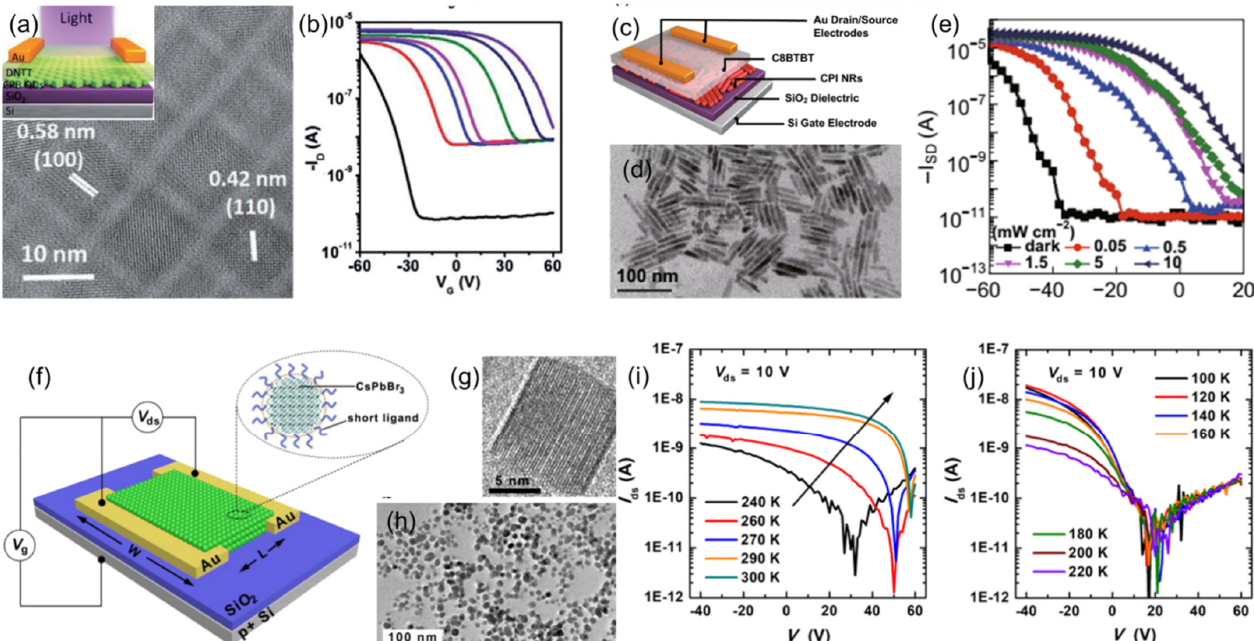
Figure 9. ( a ) HRTEM image of CsPbBr 3 quantum dots (inset: device schematic of the FET) and ( b ) transfer characteristic curves under different illumination conditions. Reproduced with the permission from ( c ) [168]. Copyright 2017, Wiley-VCH Verlag GmbH & Co. KGaA, Weinheim. ( c ) Device schematic of the bilayer FET made-up of CsPbI3 nanorods and C8BTBT, ( d ) TEM image of CsPbI 3 nanorods ( e ) transfer curves of the FETs under different light intensities [169]. Copyright 2018, Springer Nature. ( f ) Device schematic along with FET characteristic connections of the CsPbBr 3 NCs terminated with short ligands, ( g ) high- and ( h ) low-resolution HRTEM image of the CsPbBr 3 NCs and transfer characteristic curves of the CsPbBr 3 NC FETs under different testing temperatures. Reproduced with permission from, transfer characteristics of undoped CsPbBr 3 NCs FETs ( i ) from 240 to 300K and ( j ) 100 to 200K [83]. Copyright 2020, American Chemical Society.